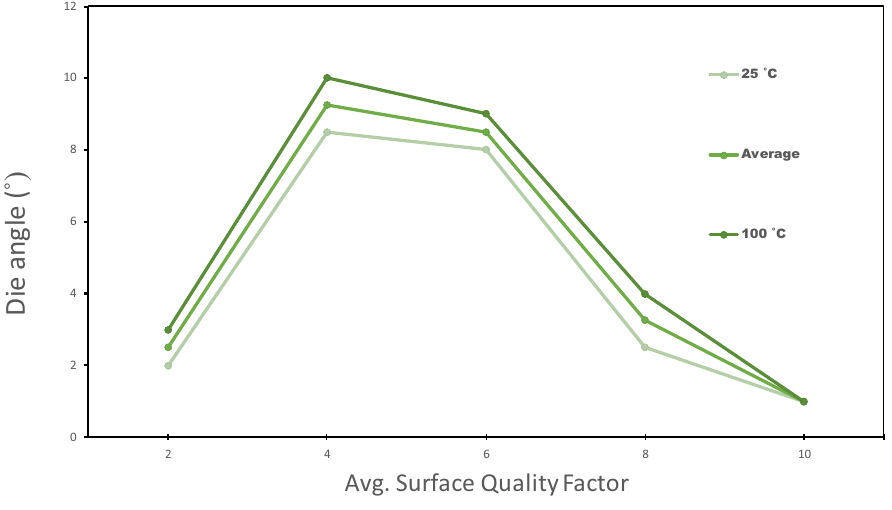
Figure 11. The average SQF vs. die angle. Ironed surfaces are adequate for can-decoration at values over